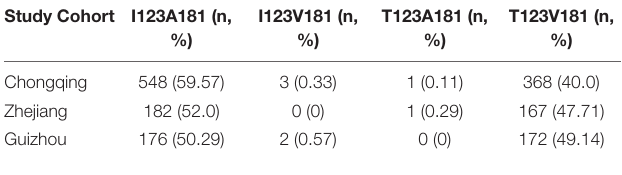
TABLE 2 | Distribution of haplotypes of CXCL16 I123T and A181V among trauma patients in three